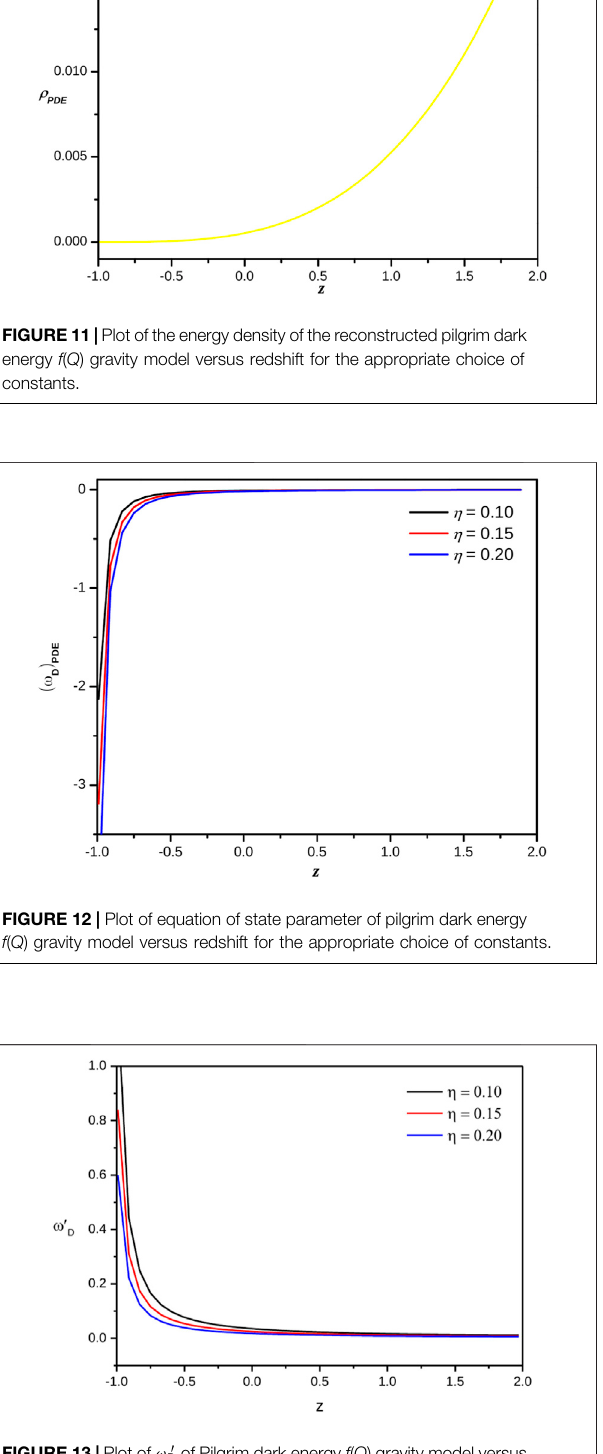
Frontiers in Astronomy and Space Sciences |